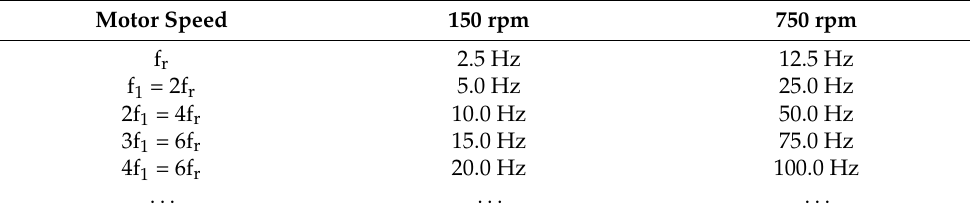
Table 2. Theoretical vibration frequencies were calculated for considered rotational frequency (f r ) and power phase frequencies (f 1